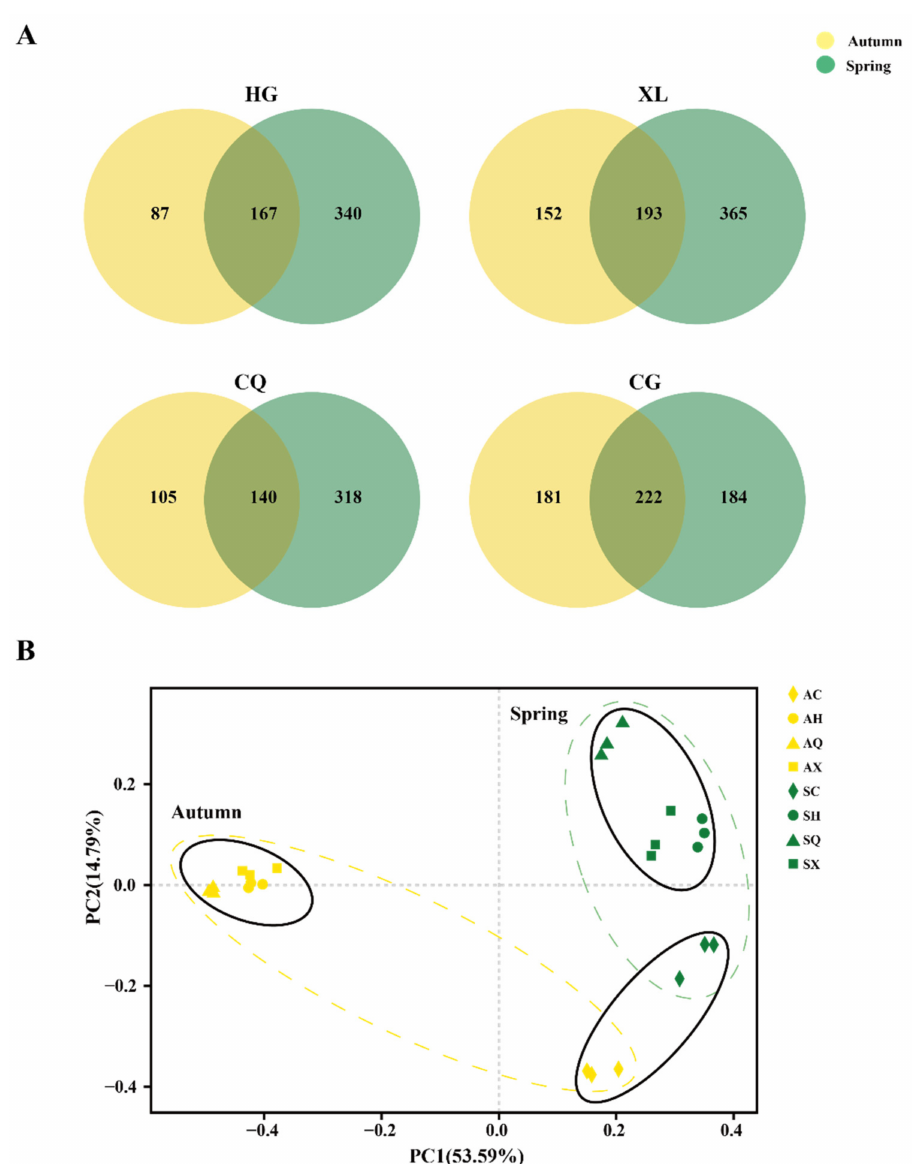
Figure 6. Comparisons of diversity in the spring and autumn samples from each mulberry cultivar. ( A ) Venn diagrams illustrating the number of OTUs in spring and autumn. Abbreviations: CQ, CG, XL and HG represent fungal communities from “Chuan Sang No.7637”, “Changguo Sang”, “Xin Lunjiao”, and “Hong Guo No.2”, respectively. Different colors represent different groups. Values represent the number of OTUs. ( B ) Principal Coordinate Analysis (PCoA) based on Bray–Curtis dissimilarity metrics for all samples using ITS data. n = 3 for each sample. Spring samples and autumn samples are represented in green and yellow colors, respectively. Abbreviations: SH, SX, SQ, and SC represent fungal communities from “Hong Guo No.2”, “Xin Lunjiao”, “Chuan Sang No.7637”, and “Changguo Sang” in spring, respectively. AH, AX, AQ, and AC represent fungal communities from “Hong Guo No.2”, “Xin Lunjiao”, “Chuan Sang No.7637”, and “Changguo Sang” in autumn,